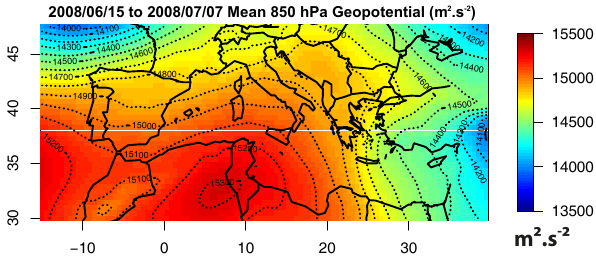
Figure 11. Mean 850hPa geopotential (m 2 s − 2 ) for the 15 June 2008–7 July 2008 period. The data are taken from 12h ERA-Interim